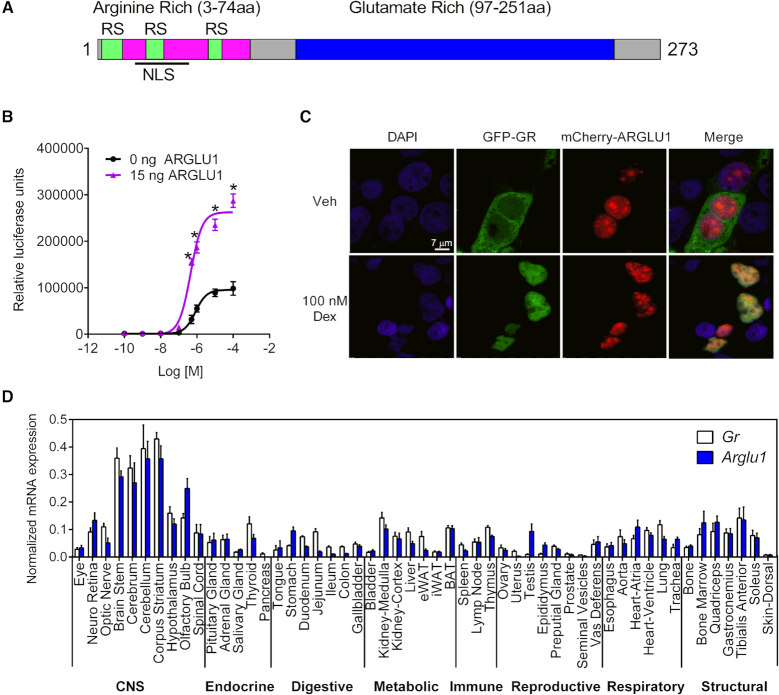
ARGLU1 is a GR transcriptional coactivator. (A) Schematic of ARGLU1 domains. NLS, nuclear localization sequence; RS, arginine-serine repeats. (B) HEK293 cells transfected with the GAL4-GR/UAS-luc reporter with a constant amount of CMX-ARGLU1 (15 ng/well) and increasing concentrations of cortisol. Data represent the mean ± SD. Student's t-test *P < 0.05 versus 0 ng ARGLU1. (C) GFP-GR (green) and mCherry-ARGLU1 (red) were co-transfected into HEK293 cells and treated with vehicle (EtOH) or 100 nM Dex for 4 h. DAPI (blue) was used to stain the nuclei. The Pearson's correlation coefficient for Veh is −0.03 ± 0.05 and for Dex is 0.52 ± 0.07. (D) Tissues from male C57Bl/6 mice 4 months of age were collected. Ovary and uterus were from female mice. RNA was extracted and samples were DNase treated, reverse transcribed, and analyzed by qPCR (efficiency-corrected ΔCt method). 36b4 was used as an endogenous reference RNA normalizer gene. Data represent the mean ± SD of individual qPCR well. Each tissue was pooled from at least 2 animals. eWAT, epididymal white adipose tissue; iWAT, inguinal white adipose tissue; BAT, brown adipose tissue. See also Supplementary Figures S1–S3.